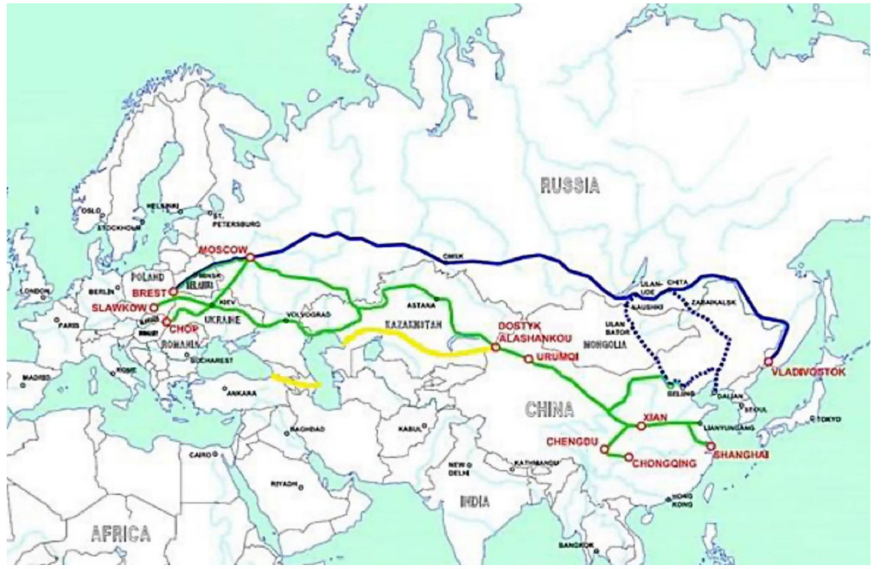
Figure 8. The main Eurasian routes of transit cargo flows in the framework of the implementation of the megaproject Economic Belt of the Silk Road (blue—main existing Trans-Siberian railways route; green and yellow—new east–west rail corridor routes via Kazakhstan) [68].